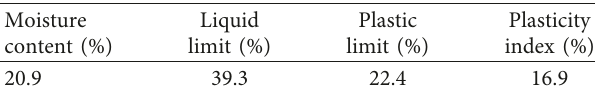
Table 2: Components in the soil sample based on particle size. Proportion of the component with different particle sizes in the soil Sand grains (mm)